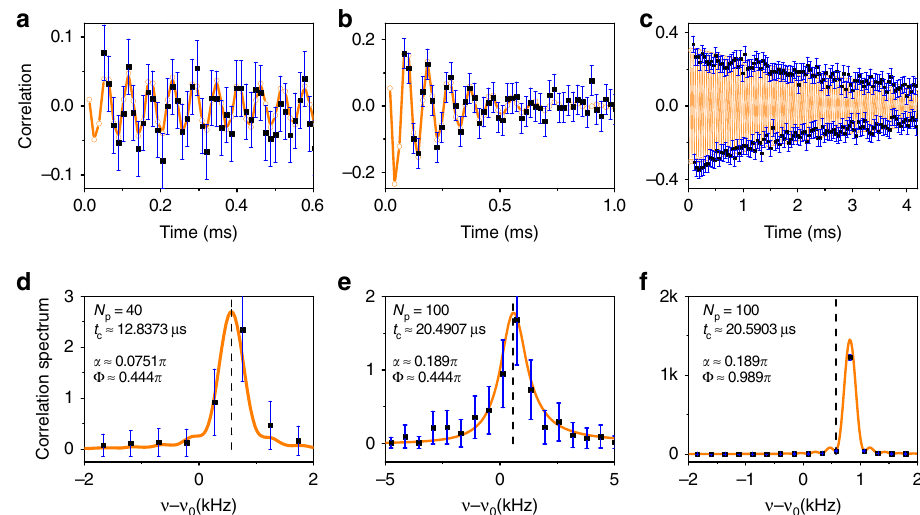
Fig. 2 Control of the measurement strength relative to the precession frequency of a nuclear spin. a – c The correlation functions of the sequential weak measurements on the nuclear spin as functions of the delay time ( Nt c ) between two measurements separated by N cycles, with t c being the duration of each measurement cycle. The dark blue error bars represent two standard deviations (2 σ ). d – f The corresponding correlation spectra. The experimental data are shown in black squares, and theoretical results are in orange lines and open circles. The interval between dynamical decoupling (DD) pulses, τ ¼ 0 : 18224 μ s, ¼ 40, is set near the resonance of the Larmor frequency ν 0 ¼ 2 : 743189 MHz. In ( a / d ), ( b / e ) and ( c / f ), correspondingly, the number of DD pulses is N p 100, and 100, the duration of one measurement cycle is t c = 12.8373, 20.4907 and 20.5903 μ s. The theoretical results reproduce the experimental data well, ¼ 1 : 142 kHz and A ¼ 16 kHz. This yields the precession angle Φ ¼ 0 : 445 π ; 0 : 443 π and 0 : 990 π , as well as the with the hyper fi ne coupling parameters A ? Z conditional phase shift α = 0.0743 π , 0.186 π and 0.186 π , correspondingly in ( a / d ), ( b / e ) and ( c / f ). The vertical dashed lines in ( d ), ( e ) and ( f ) mark the positions of the hyper fi ne-modi fi ed precession frequency (cid:2) ν (cid:3) ν 0 . All error bars were calculated as explained in Supplementary Note 5. Source data